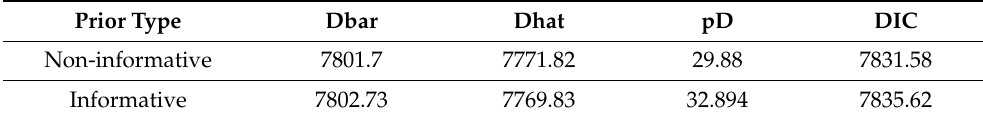
Table 3. DIC for informative and non-informative.